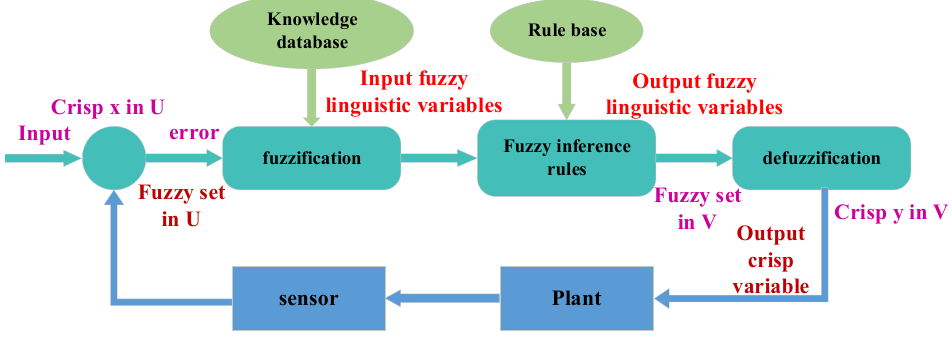
Figure 12. Block diagram of fuzzy logic controller.